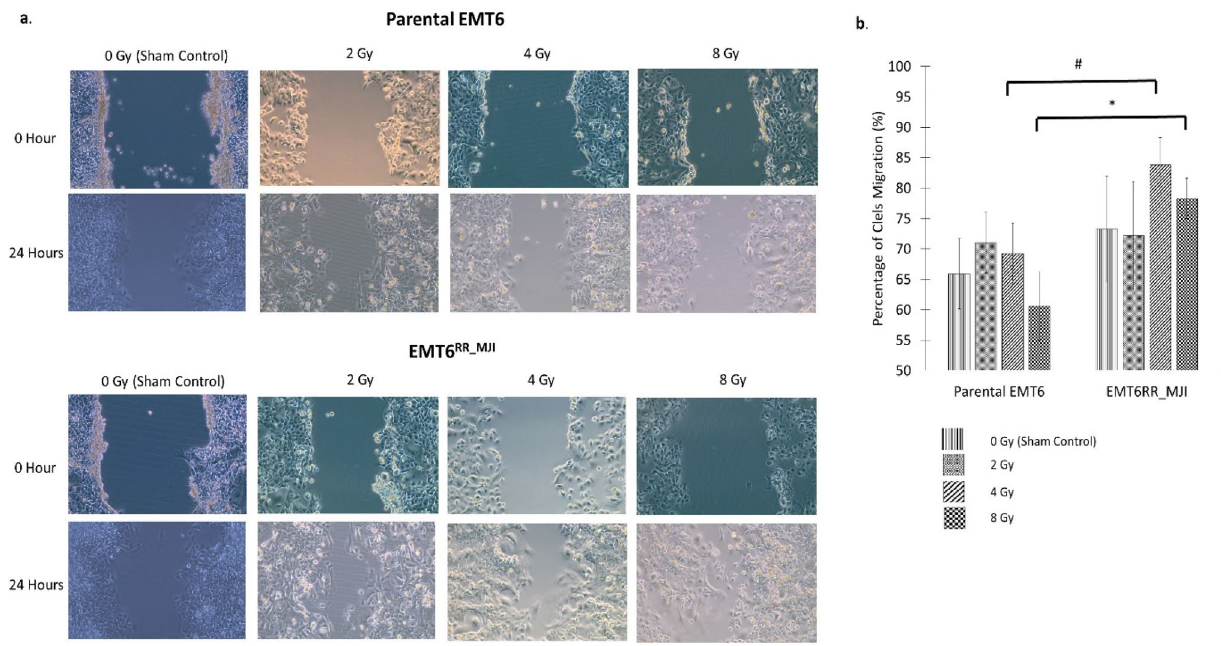
Figure 3. ( a ) Cell migration detected using scratch assay of EMT6 RR_MJI and parental cells in treated and sham control groups, 24 h post-irradiation. ( b ) EMT6 RR_MJI showed increased migration to 4 Gy and 8 Gy gamma-ray irradiation compared to parental cells after 24 h. ( # p < 0.01, *p < 0.05) (Data n = 3 ±